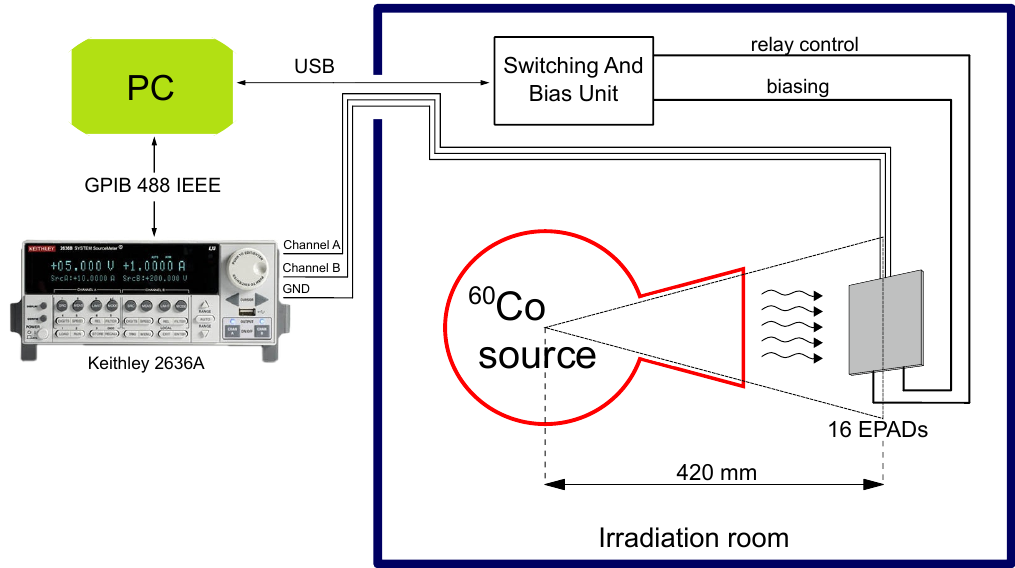
Figure 10. Experimental setup in irradiation room at Institute of Nuclear Sciences